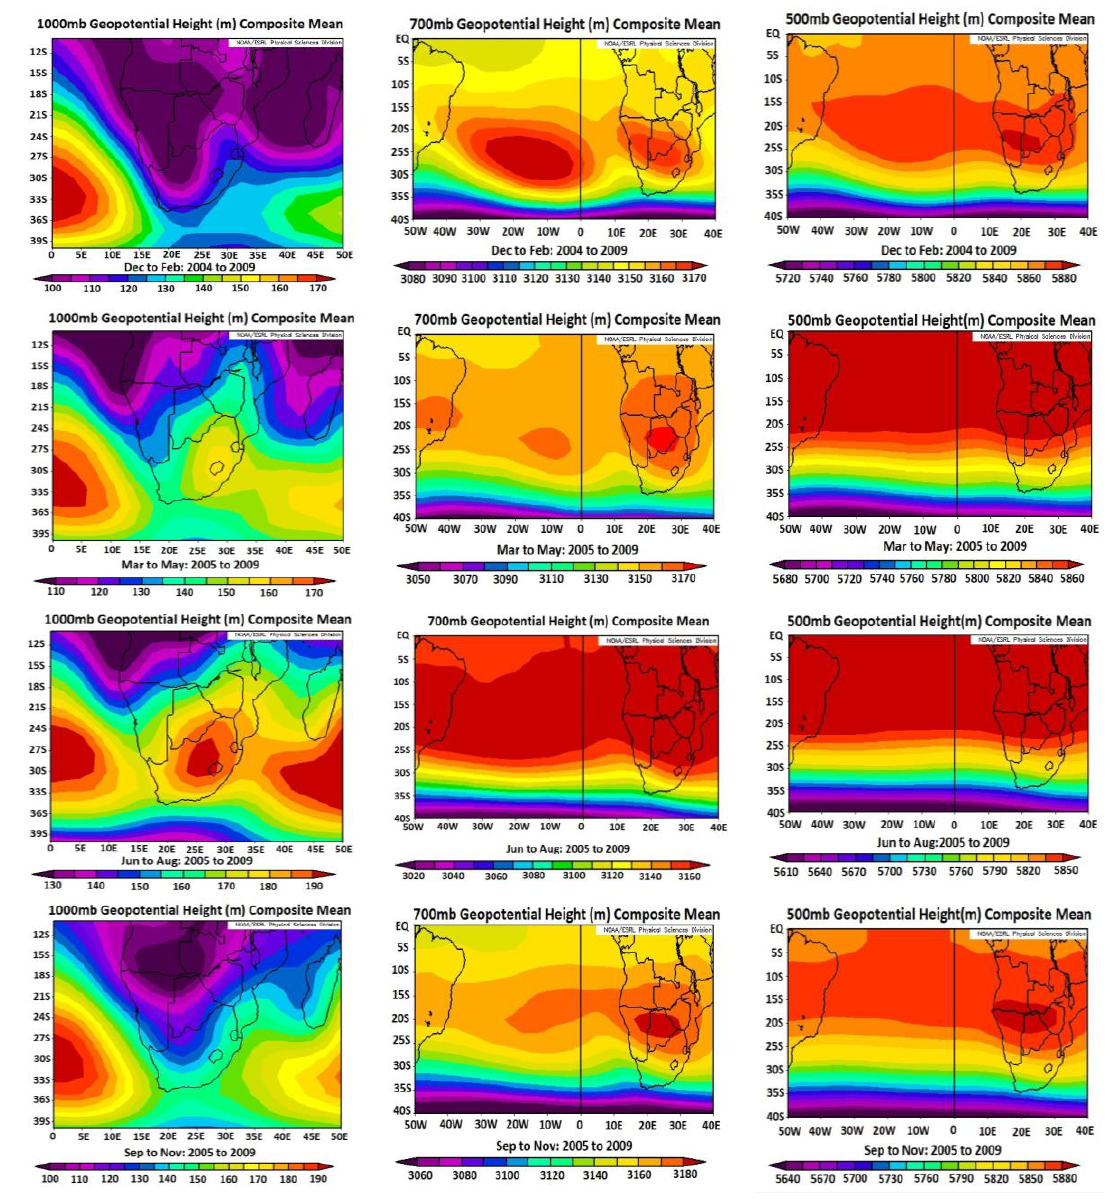
Figure 5. Composite mean seasonal geopotential height (m) over Southern Africa, South Atlantic, and Indian Ocean at the 1000, 700, and 5500 hPa pressure levels during the 2004–2009 period, constructed using National Centers for Environmental Prediction and National Center for Atmospheric ResearchNCEP and NCAR reanalysis data. From the ( top ) to the ( bottom ) row is the seasonal change from DJF to SON, while the ( left ), ( middle ), and ( right ) columns represent the pressure levels at 1000, 700 and 500 hPa, respectively.